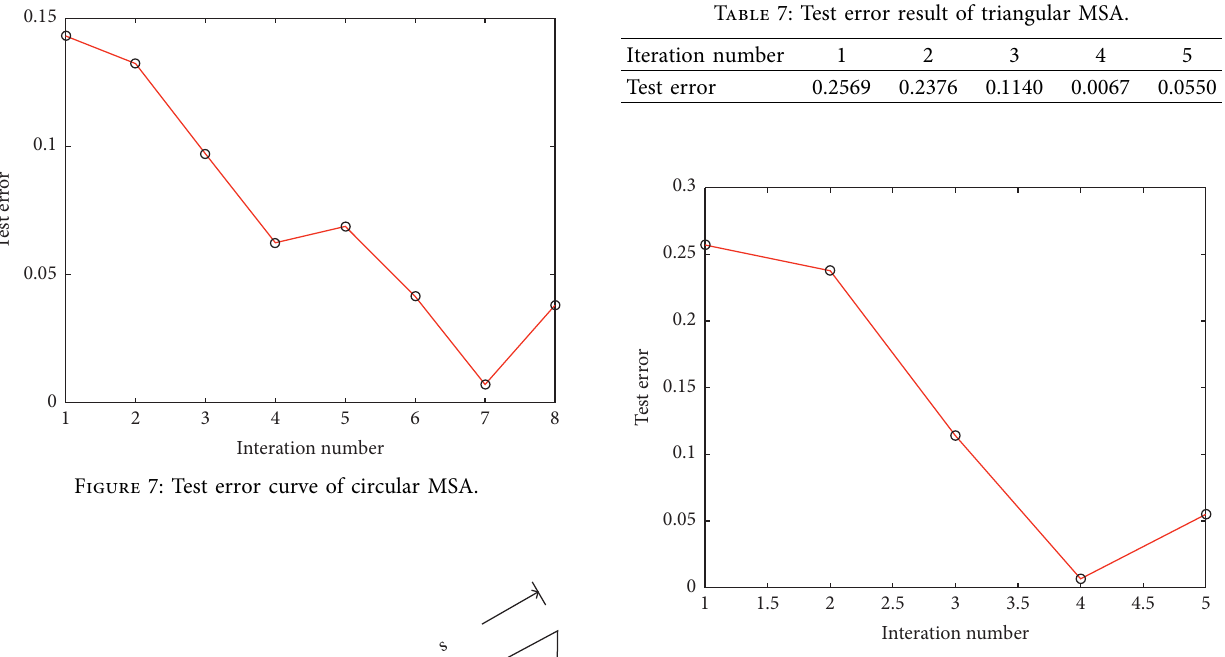
Figure 9: Test error curve of triangular